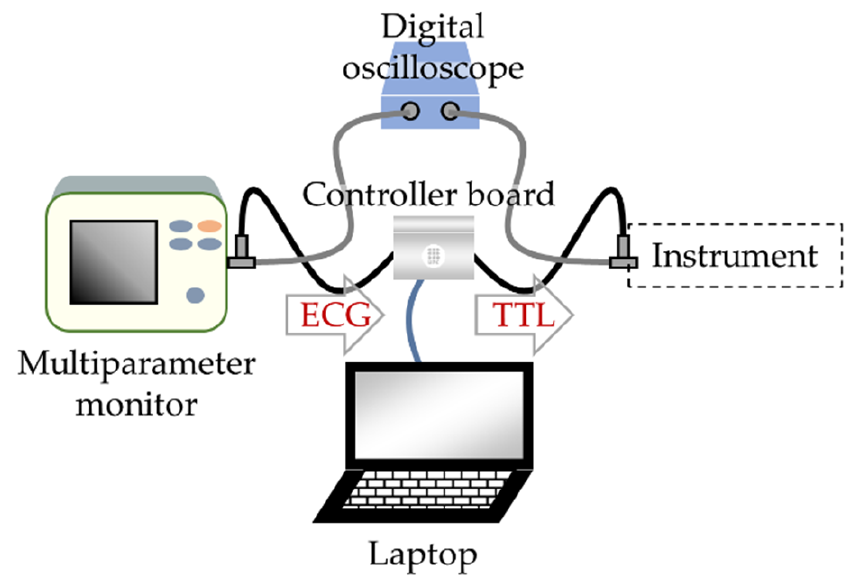
Figure 1. Block diagram of the hardware set-up comprising a controller board, a multiparameter monitor to capture and record the ECG, and a digital oscilloscope. The laptop and oscilloscope are used to oversee the ECG to TTL conversion during the development tests. They can be suppressed once development is complete.